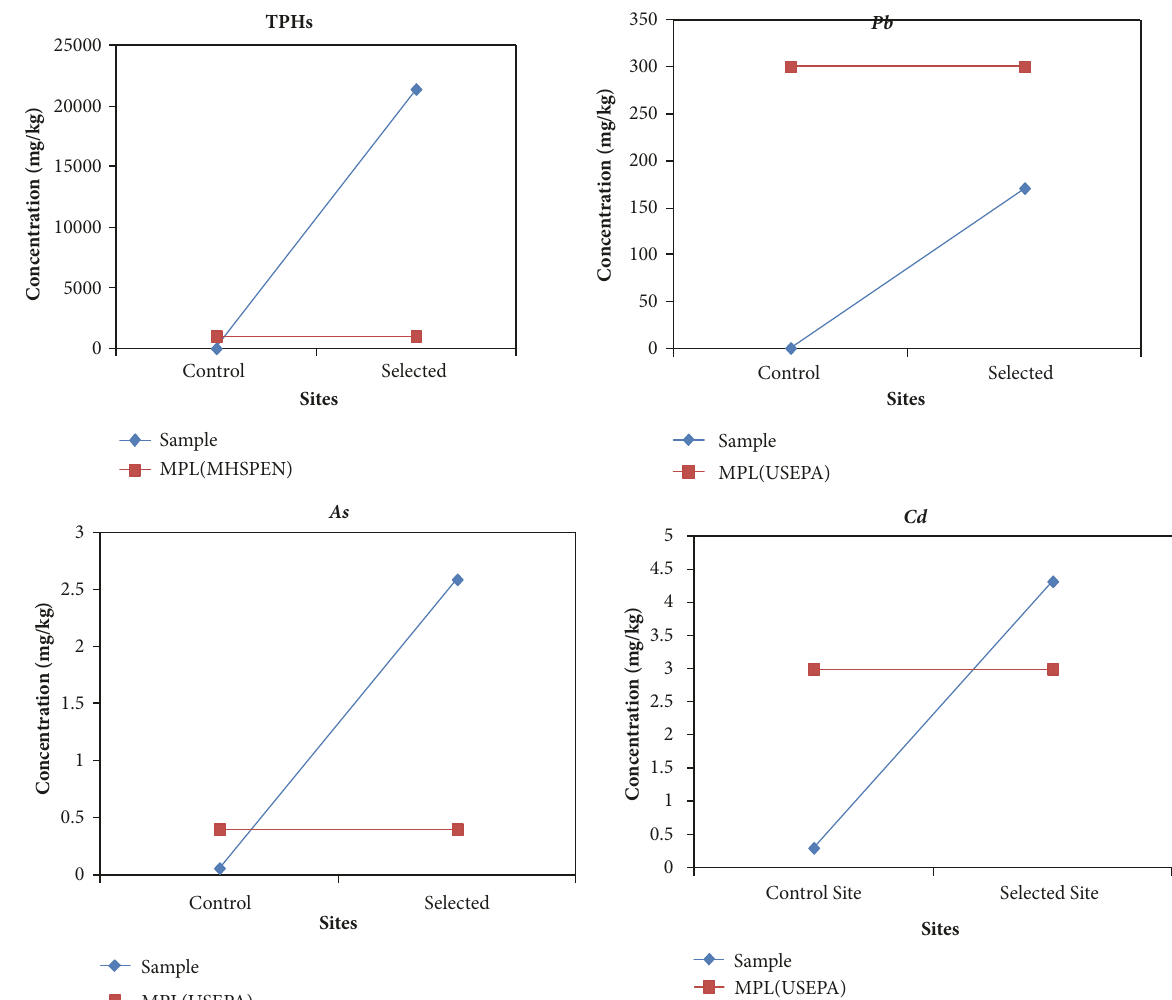
Figure 2: Comparison of TPHs and heavy metal concentration levels with standards